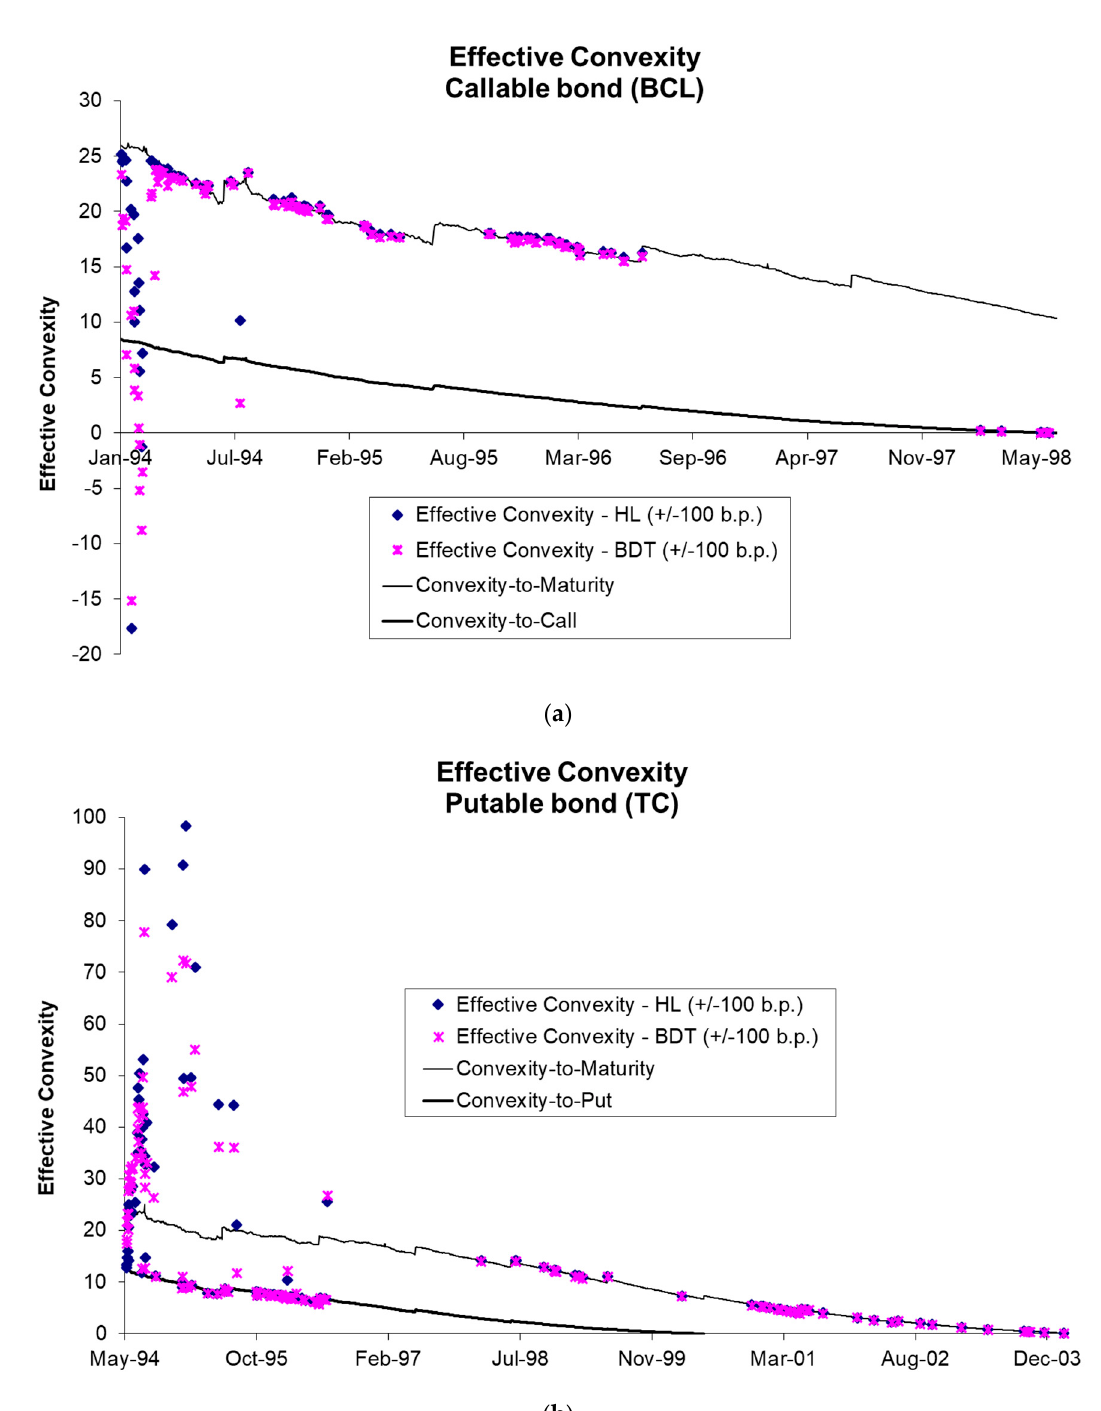
Figure 3. Evolution of the effective convexity (EC) estimated from the HL model and the BDT model. Upper and lower black lines are the convexity-to-maturity and the convexity-to-option. Both lines limit the possible values of the EC according to the expectation of exercising the option. ( a ) shows the results for the Callable bond (BCL) and ( b ) for the Putable bond (TC).